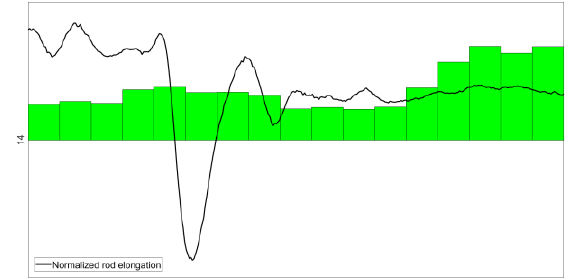
Fig. 9. Variation of signal measured by the device instrumentation (DA sensor) and S/B ratio evolution deduced from the hodoscope detectors for the row 14, for a time range [t0+375ms; t0+392 ms].